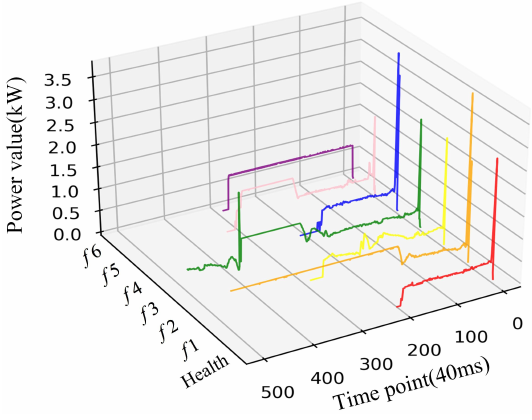
Figure 2. Turnout failure power curve. Table 1. Six kinds of fault phenomena and causes of